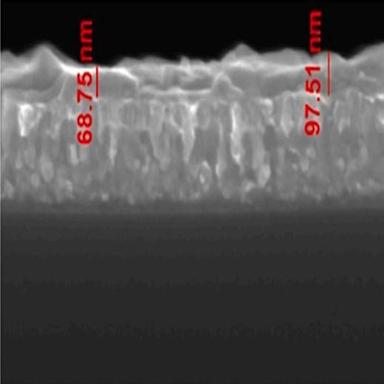
s) surface and x) cross-section SEM images obtained at 30 kV with 50 k magnification of BZT thin films deposited at: a) 350º C, 60 min; then b) annealed at 550º C, 60 min in O2. Deposited at c) 550º C, 50 min with O2:Ar.= 50%.